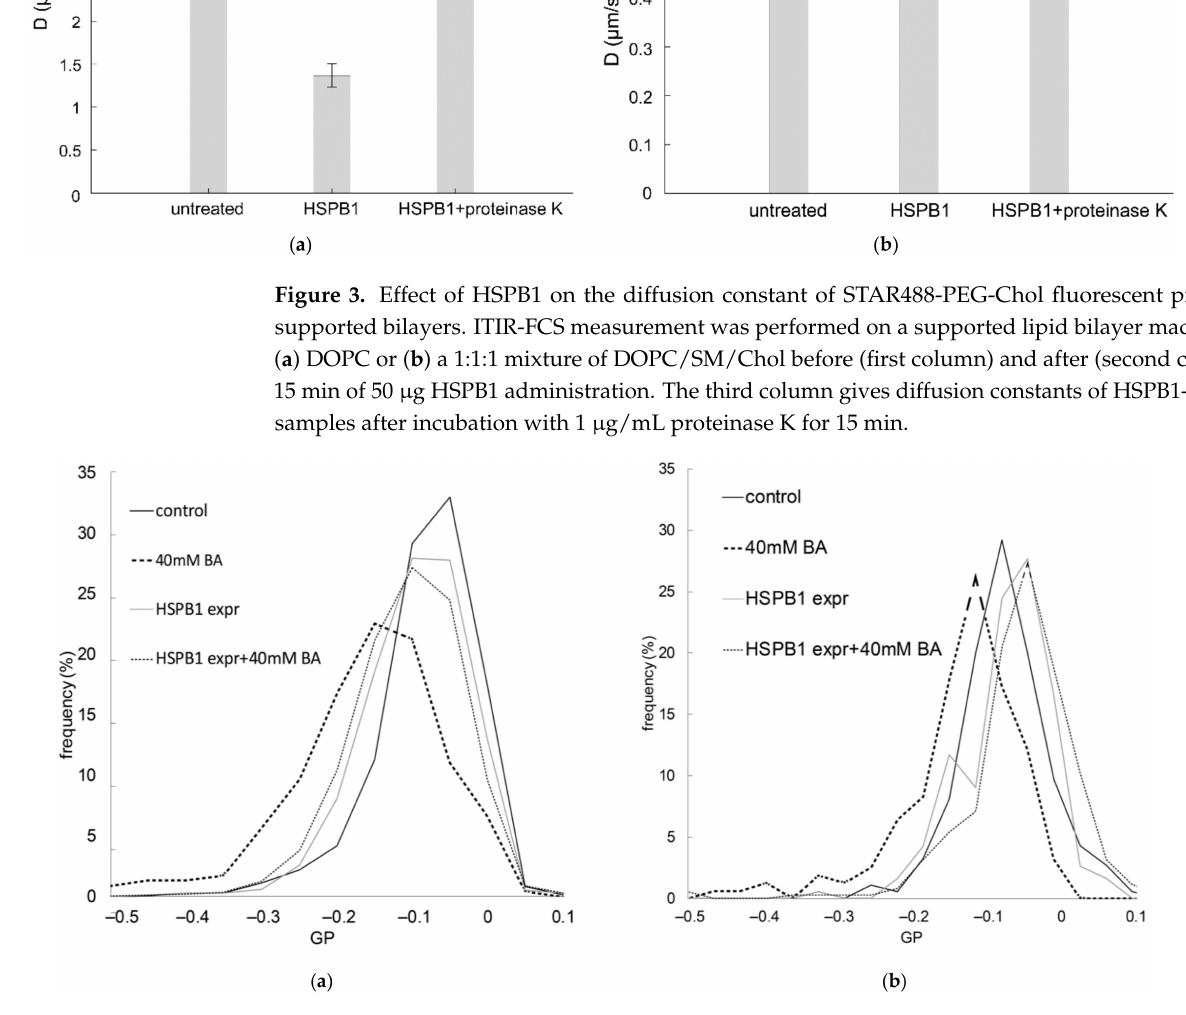
Figure 4. Effect of HSPB1 on membrane order impaired by benzyl alcohol (BA) . Membrane order was monitored by calculating the general polarization (GP) of the di-4-ANEPPDHQ environment- sensitive probe. Control and HSPB1-overexpressing ( a ) B16-F10 cells and ( b ) E. coli cells were pretreated with 40 mM BA for 15 min after HSPB1 expression. GP values were read out from processed and segmented fluorescence images and the distribution was plotted as a histogram. The Kolmogorov–Smirnov test was performed to analyze the equality of GP distributions in sample pairs. Control and BA-treated samples differed from each other significantly ( p < 0.05), but GP distribution was equal in cells overexpressing HSPB1 with and without BA